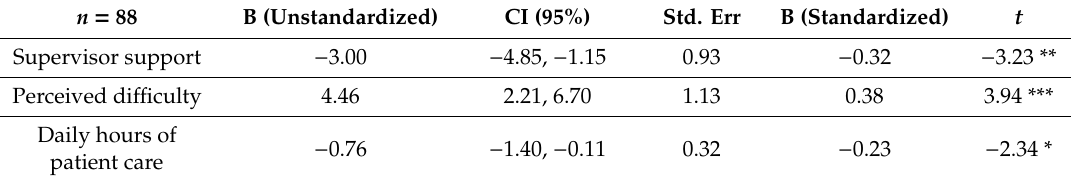
Table 4. Linear regression model results for the emotional exhaustion subscale.